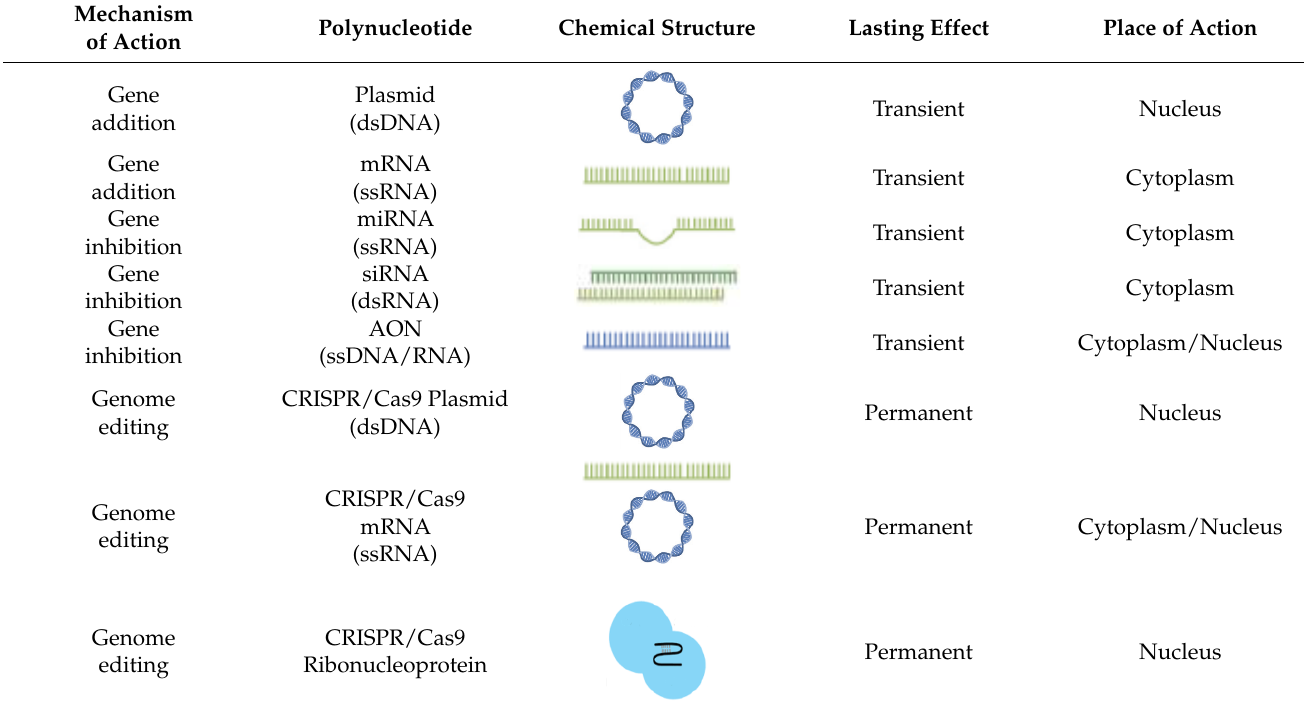
Table 1. Scheme of essential characteristics and properties of main polynucleotides used in oligo-based gene therapeutics and gene therapy.